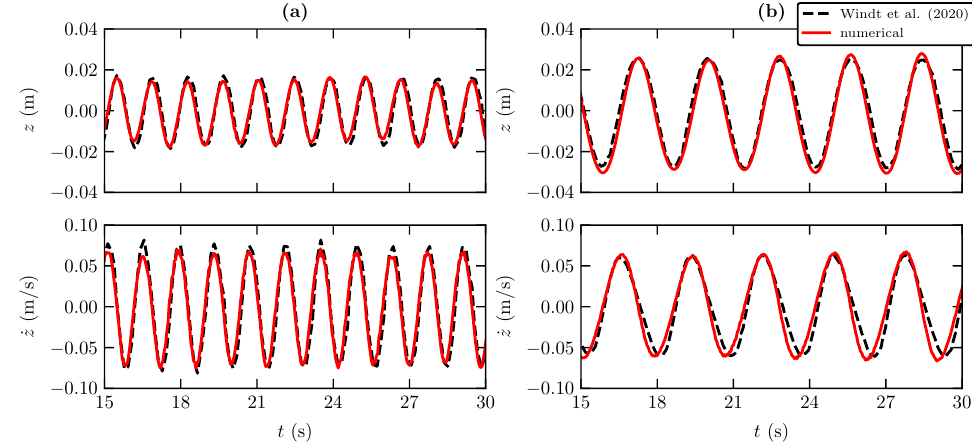
Figure 5. Time series of position (top) and velocity (bottom) of the PTO system with D = 200 Nms for ( a ) Test 3 and ( b ) Test 4 [43].